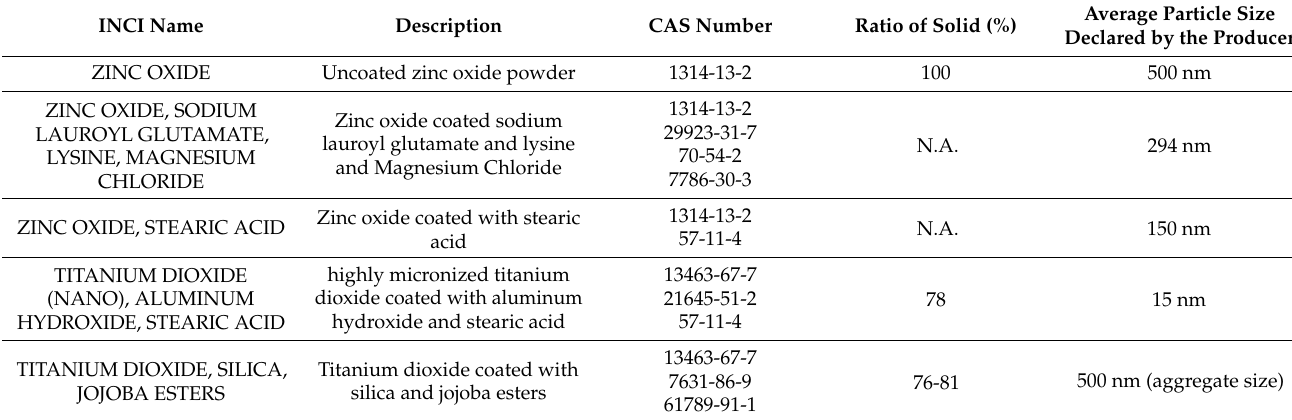
Table 1. Inorganic UV filters selected for this study.